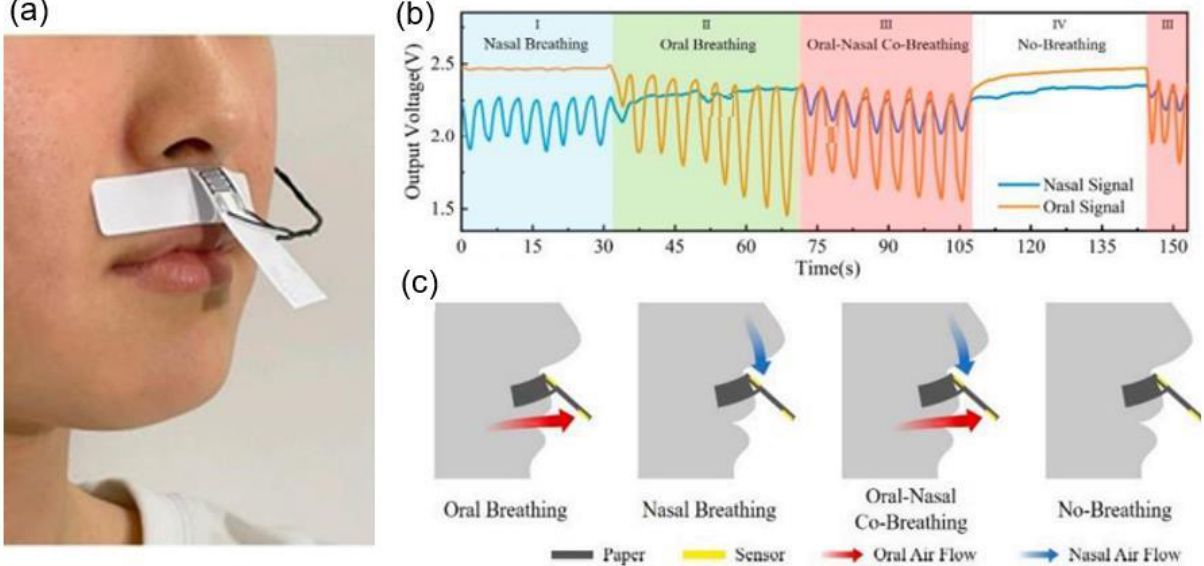
Figure 4. ( a ) Photo of a volunteer wearing a PB humidity sensor patch. ( b ) Simulated breathing experiments for different breathing modes and various respiratory patterns. ( c ) Schematic diagram of oral and nasal airflows in four respiratory patterns. PB humidity sensors was fabricated on printing paper. The graphite ink was screen-printed for fabrication interdigital electrode pattern. For the purpose of distinguishing between oral and nasal respiratory signals, two graphite screen electrodes were printed separately on both sides of the printing paper. Reprinted from [31]. Published 2022 by MDPI as open access.